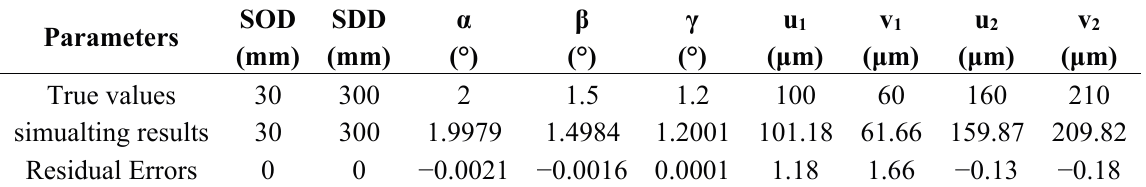
Table 2. Simulation results without errors in extracting centers.